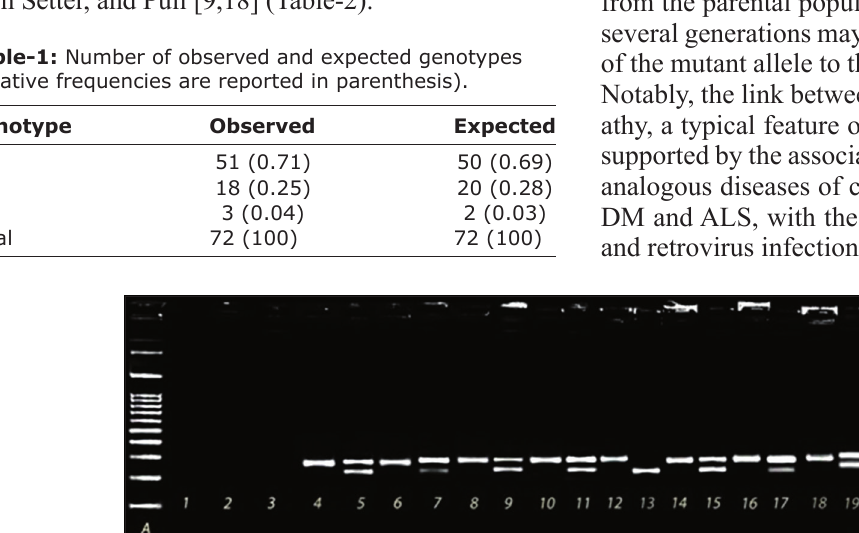
Figure-1: Agarose gel electrophoresis of the polymerase chain reaction (PCR) and restriction fragment length polymorphism (RFLP) products of representative samples tested for the detection of the (SOD1:c.118G>A) gene mutation. Lane A. DNA 100 bp Ladder (Nippon Genetics, Europe GmbH). Lanes 1-3. Negative controls (samples containing water instead of DNA) for DNA isolation (lane 1), PCR (lane 2), and RFLP-PCR (lane 3). Lanes 4, 6, 8, 10, 12, 14, 16, 18, 20, and 22. PCR amplification products of the SOD1 gene. Lanes 5, 7, 9, 11, 13, 15, 17, 19, 21, and 23. The outcome of RFLP analysis conducted on PCR products using the restriction endonuclease AcuI for the GA genotype (lanes 5, 7, 9, 11, 15, 17, 19, and 23), the GG genotype (lane 13), and the AA genotype (lane 21).